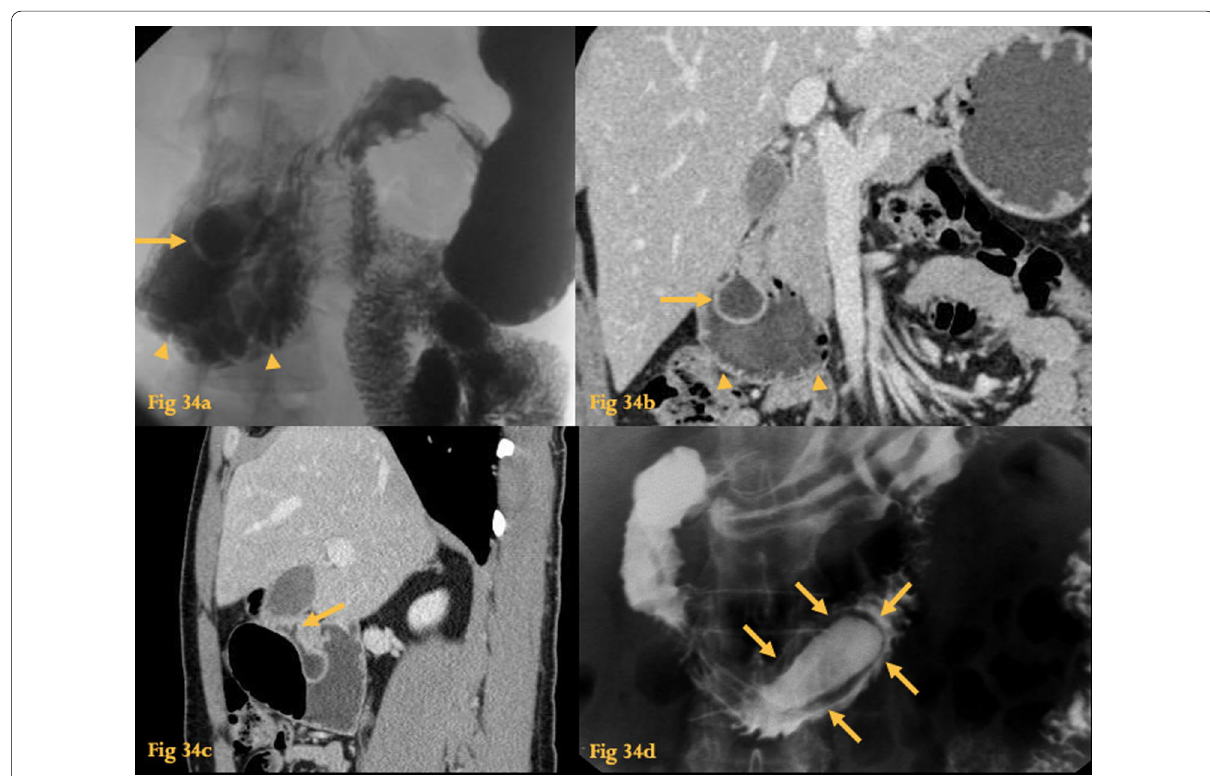
Fig. 34 Intraluminal diverticulum. UGIS ( a ) shows a barium‑filled sac surrounded by a radiolucent halo in D2 (arrow). Duodenal luminal dilatation and mucosal fold thickening are also noted (arrowheads). Abdominal CT ( b ) of the same patient with analogous findings. Sagittal reformation ( c ) clearly shows the attachment of the intraluminal diverticulum to the duodenal wall (arrowhead). UGIS of another patient ( d ) with an intraluminal diverticulum shows a radiolucent line surrounded by barium both inside and outside